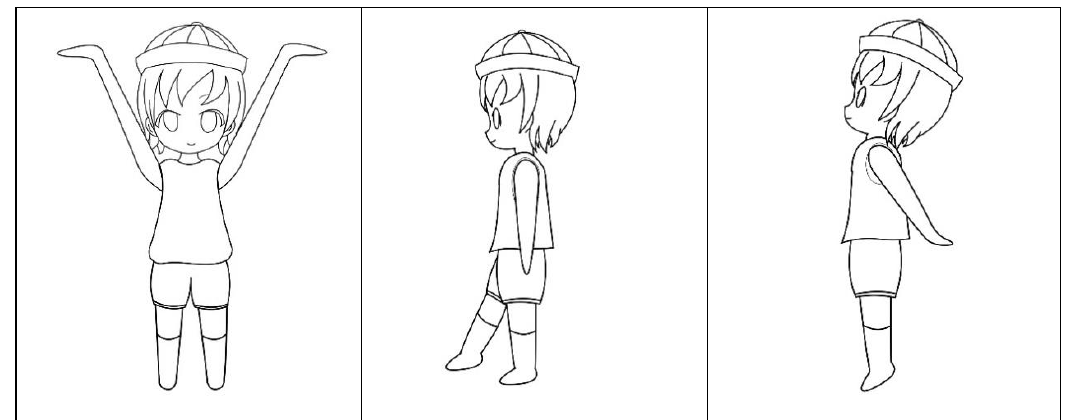
Figure 2. Illustration of dynamic focus training actions.